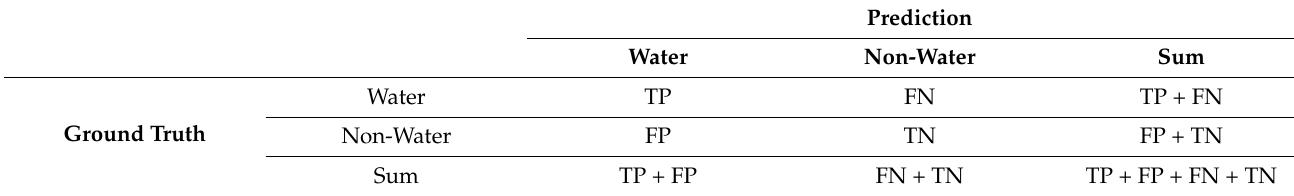
Table 2. Confusion